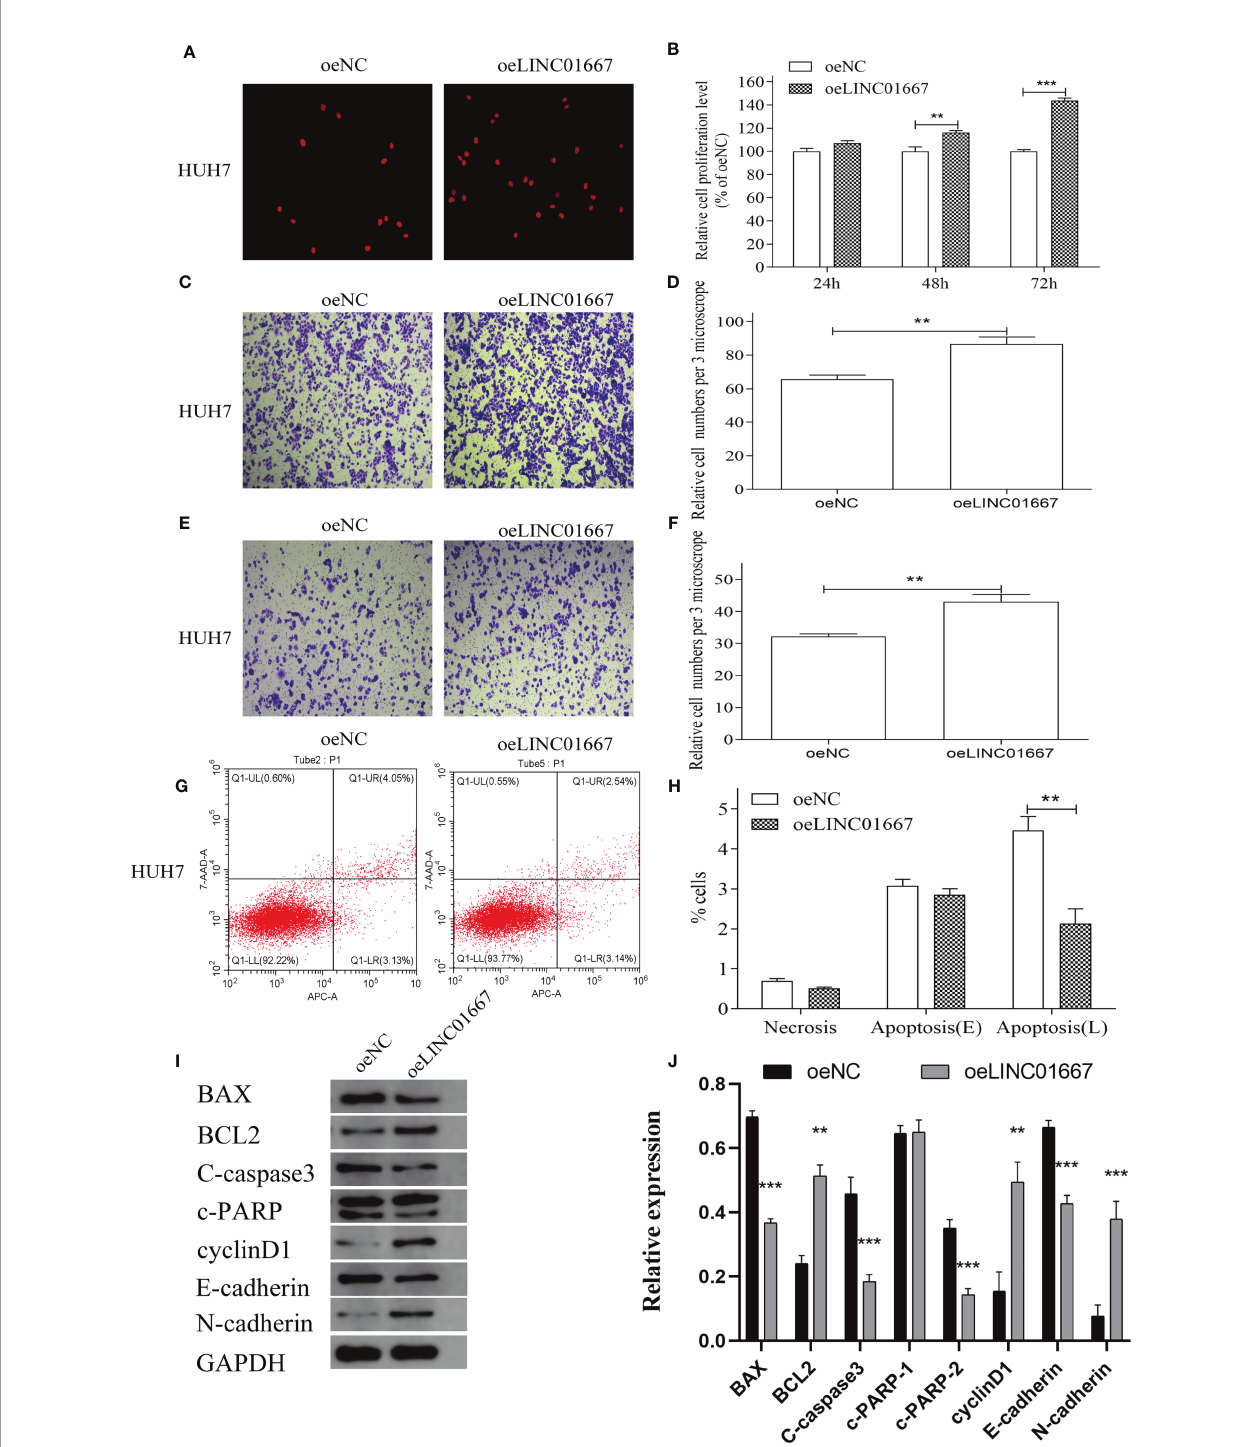
FIGURE 5 | Overexpression of LINC01667 in HUH7 cells can promote cell proliferation, migration, and invasion, and inhibit apoptosis in vitro . (A, B) Proliferation potential in HUH7 cell lines at 24, 48 and 72h in stable LINC01667 overexpressing cells. **P<0.01, *** P < 0.001. (C, D) Migration potential in HUH7 cell lines at 48h in stable LINC01667 overexpressing cells. ** P <0.01, *** P < 0.001. (E, F) Invasion potential in HUH7 cell lines at 48h in stable LINC01667 overexpressing cells. ** P <0.01, *** P < 0.001. (G, H) Overexpressed of LINC01667 inhibited cell apoptosis (*** P < 0.001). (I, J) Western blot was used to analysis the expression of